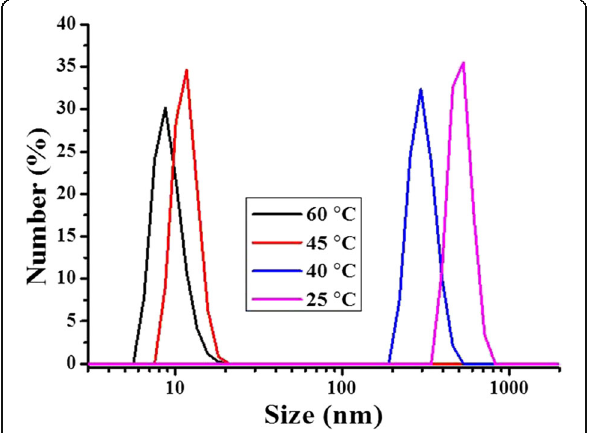
Fig. 6 Diameter of P(OEGDA-MAA) hydrogels in ethanol (1 mg/mL) at different temperature